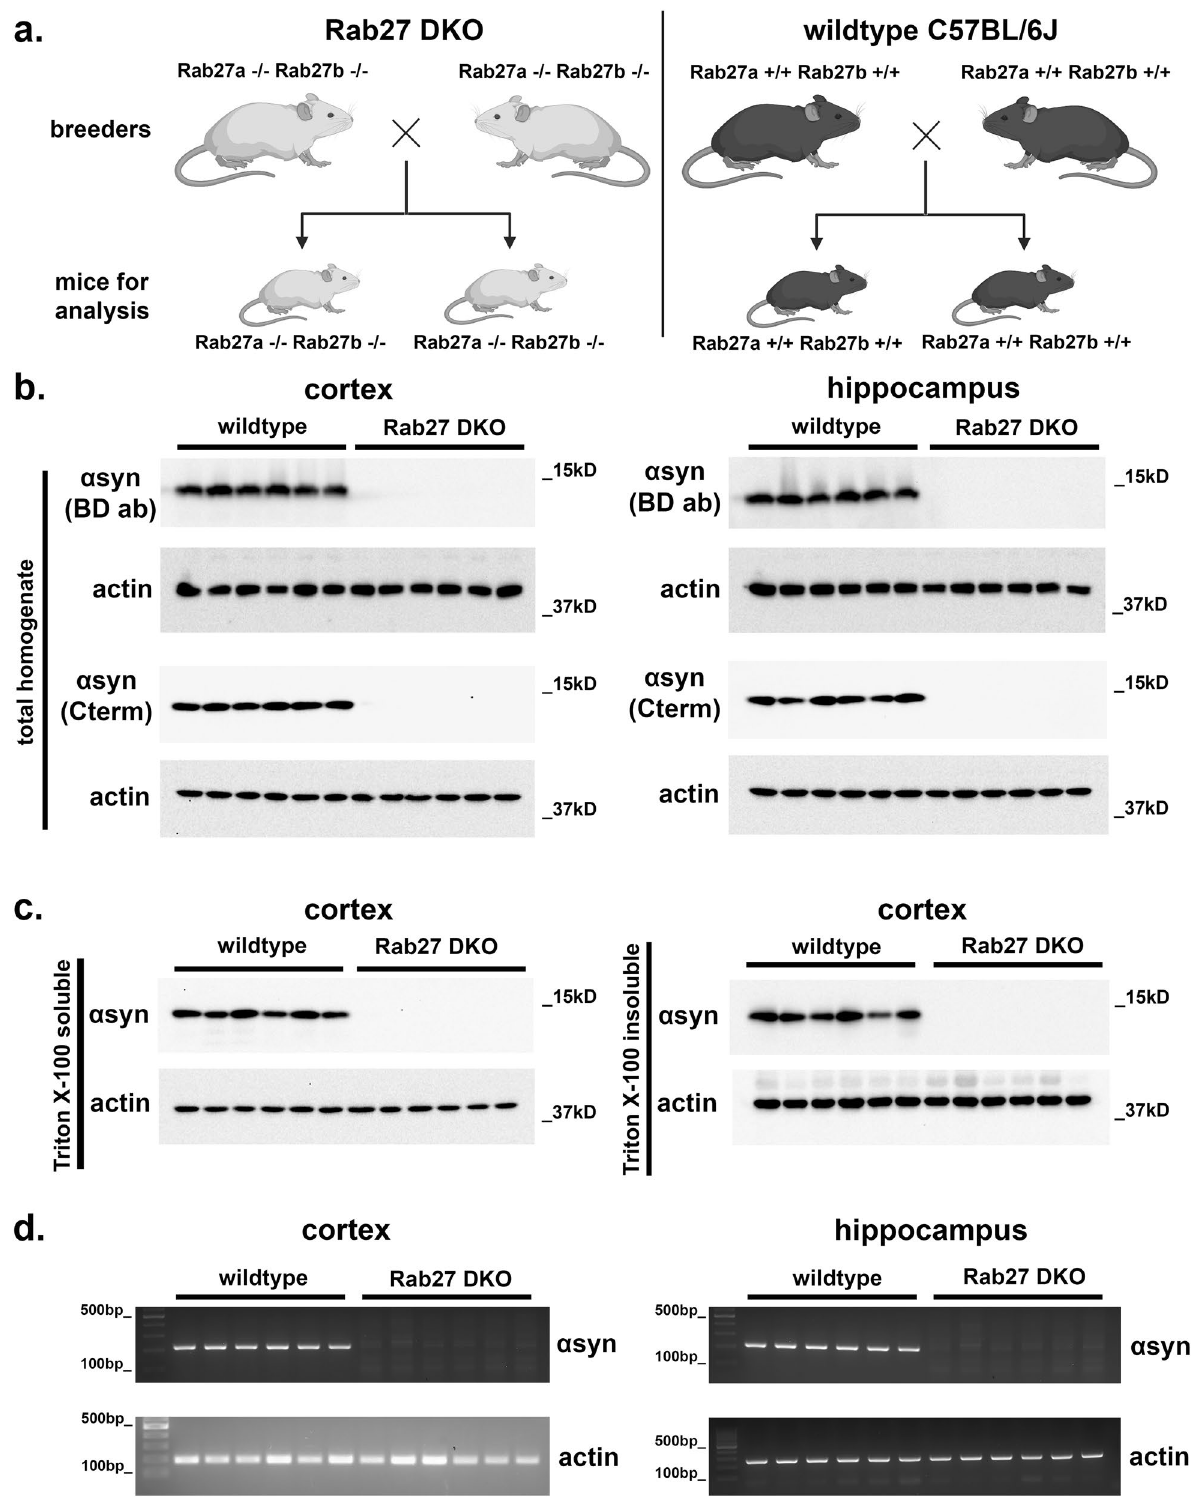
Figure 1. Rab27 DKO mouse brains lack αsyn expression. ( a ) Breeding scheme for Rab27 DKO mice and wildtype C57BL/6J mice used for this study. Briefly, Rab27 DKO mice were bred in homozygous non-litter mate pairs. Since the Rab27 DKO mice were generated in the C57BL/6J strain, we compared the Rab27 DKO mice to C57BL/6J mice obtained from Jackson Laboratories. ( b ) Total homogenates from the cortex and hippocampus of 4 week-old wildtype C57BL/6J mice and Rab27 DKO mice were analyzed by Western blot using two different αsyn antibodies, one directed at an epitope within the protein (BD αsyn antibody #610787) and another one directed at a C-terminal epitope (Cell Signaling αsyn antibody #2642S). N = 6 per genotype. ( c ) Triton X-100 soluble and Triton X-100 insoluble lysates from the cortex and hippocampus of 4 week-old wildtype C57BL/6J mice and Rab27 DKO mice were analyzed by Western blot. N = 6 per genotype. ( d ) RNA samples from the cortex and hippocampus of 4 week-old wildtype C57BL/6J mice and Rab27 DKO mice were examined for αsyn mRNA expression by RT-PCR. N = 6 per